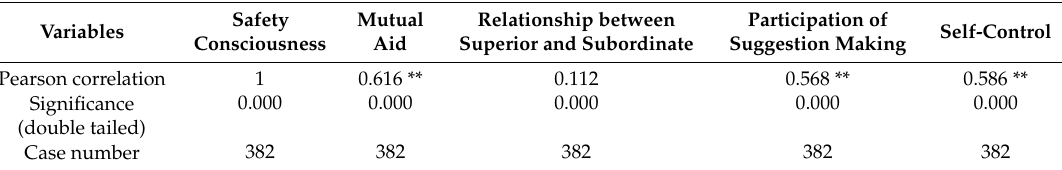
Table 10. Correlation analysis between safety consciousness and various dimensions of safety citizenship behaviour.